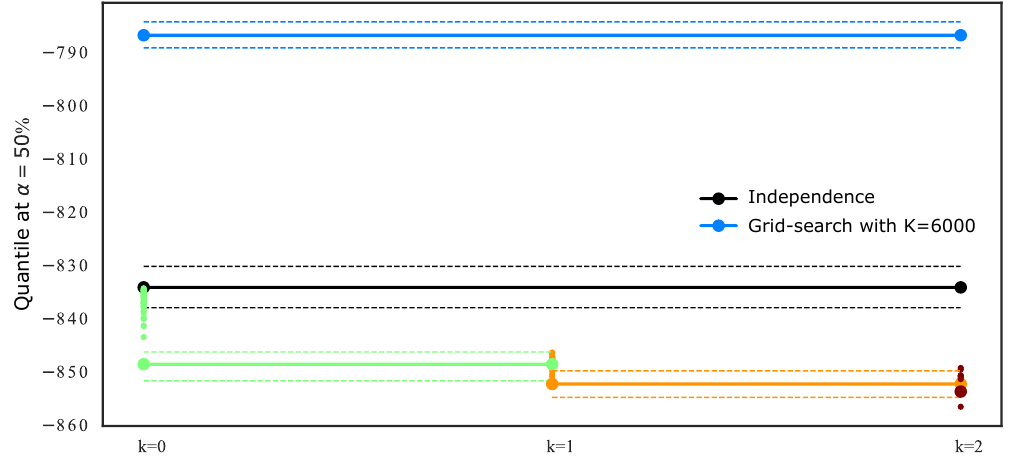
Figure 5: Minimization of the output quantile in function of the iteration k . The green and the orange lines respectively show the minimum quantiles obtained from the first and second iterations from Method 2. The quantile at independence is shown in black and the quantile obtained using Method 1 is shown in blue. The 95 % bootstrap confidence intervals are also displayed for the independence and each